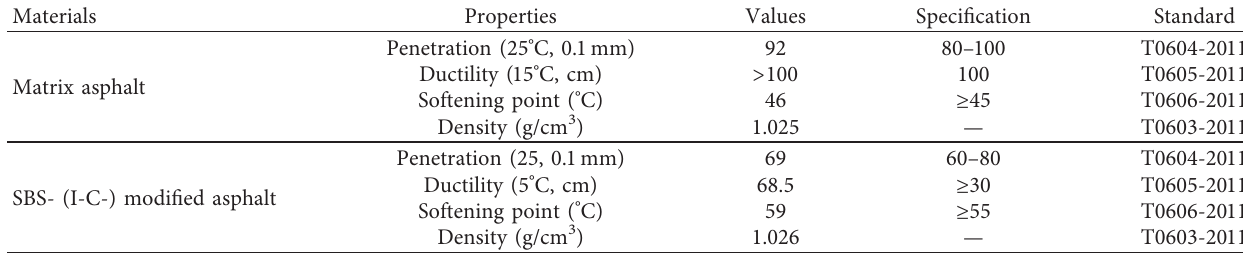
Table 1: Basic properties of binders.